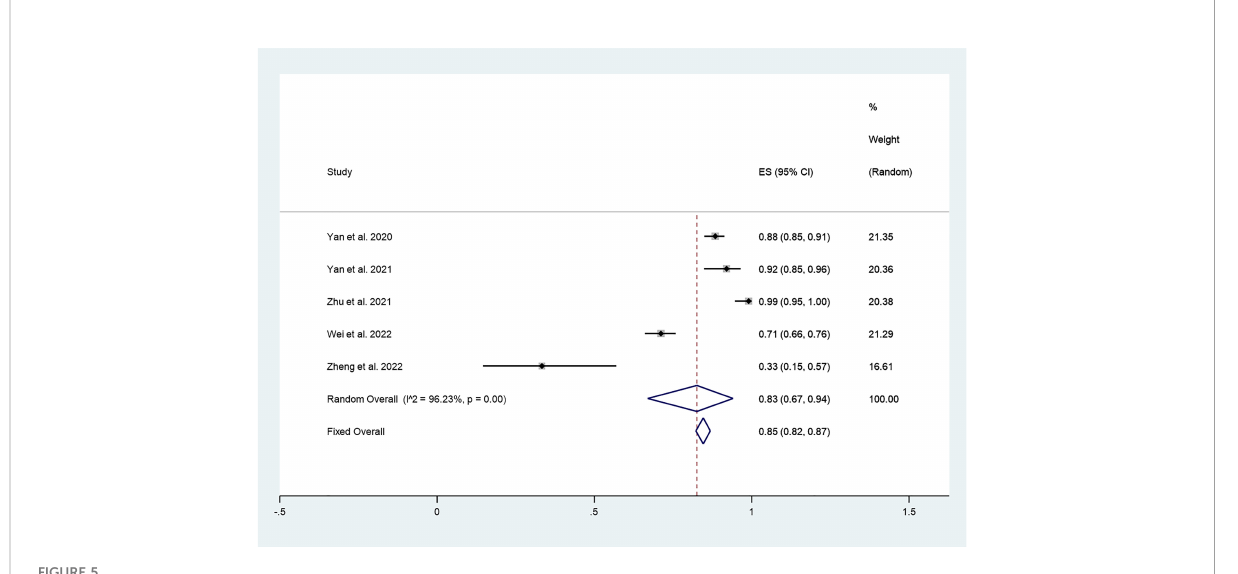
FIGURE 5 CDR after thermal ablation at 3-years follow-up.